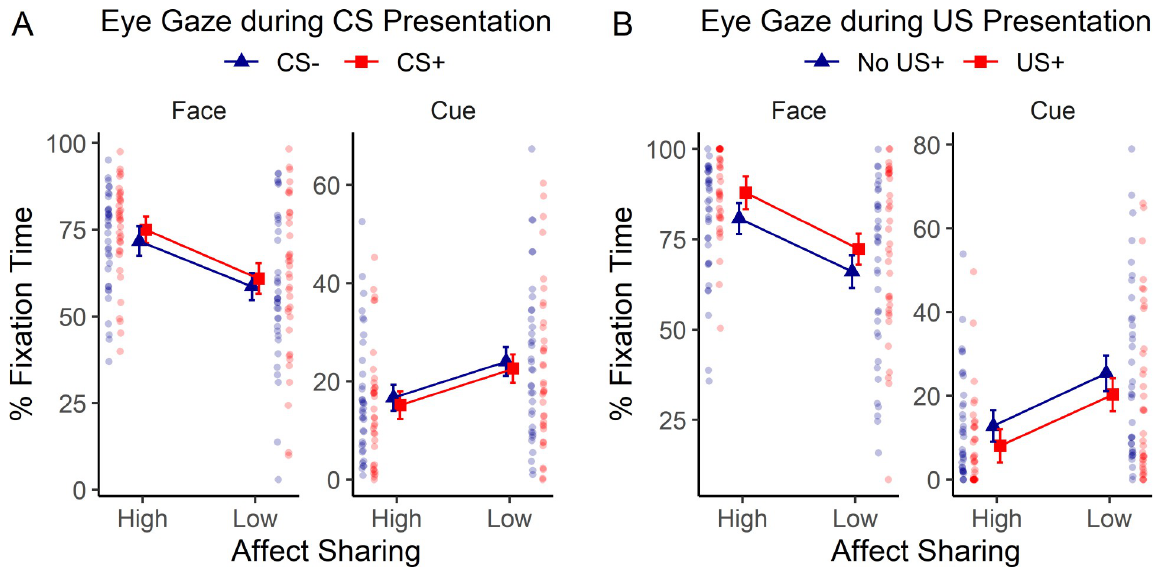
Fig 5. Eye tracking results of the learning stage. Average fixation times at the cue (CS) and face area of interest, expressed as % of total fixation time, recorded during the presentation of (a) the CS and (b) the US are shown separately for the high / low affect sharing condition. Error bars reflect 95% confidence intervals corrected for within-subject designs. Results of individual participants are shown laterally as semi-transparent dots.